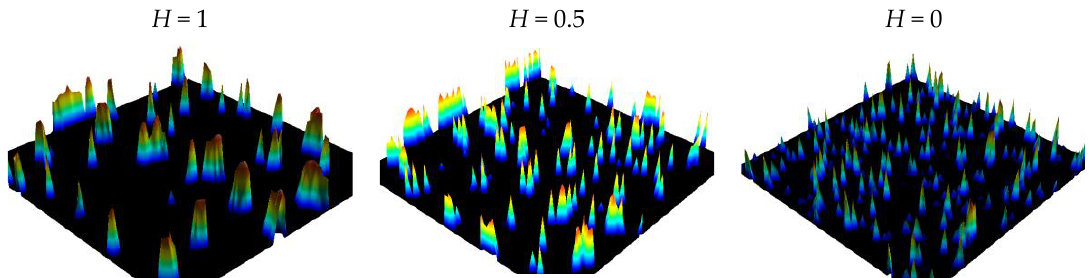
Figure 3. Results of the pressure distribution for the three surfaces described in Figure 1 with 3 Hurst exponents.